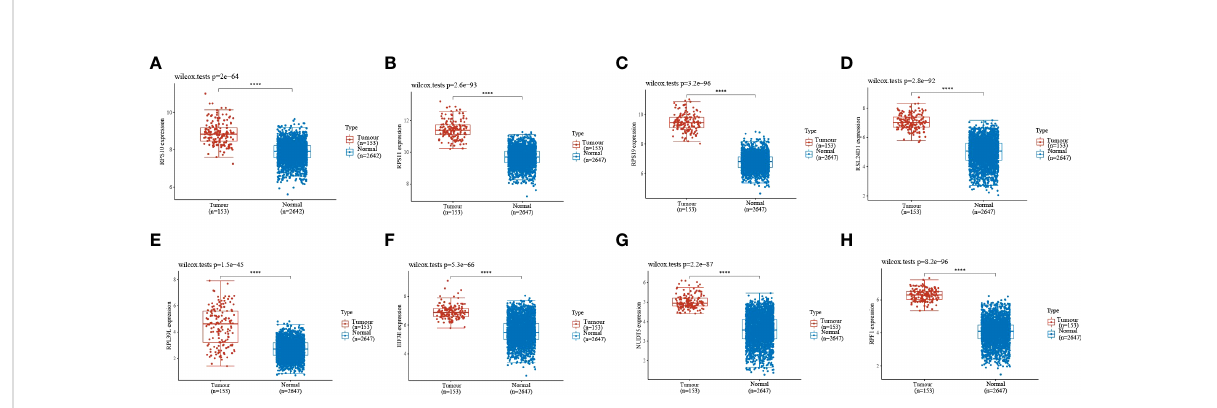
FIGURE 4 Expression validation of the eight genes in the LASSO formula. (A – H) The expression validation of the eight genes in the LASSO formula showed that all eight genes were highly expressed in gliomas. Red indicates tumor samples, and blue indicates normal samples. Prognostic gene expression validation. ****indicates